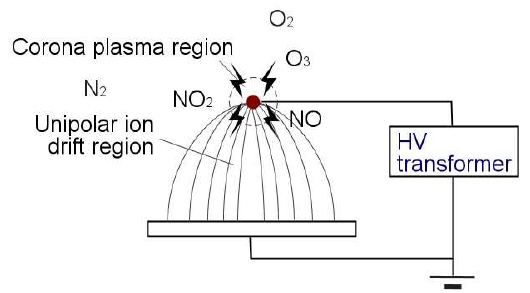
Figure 3. Schematic of the production of by-products by corona discharge.